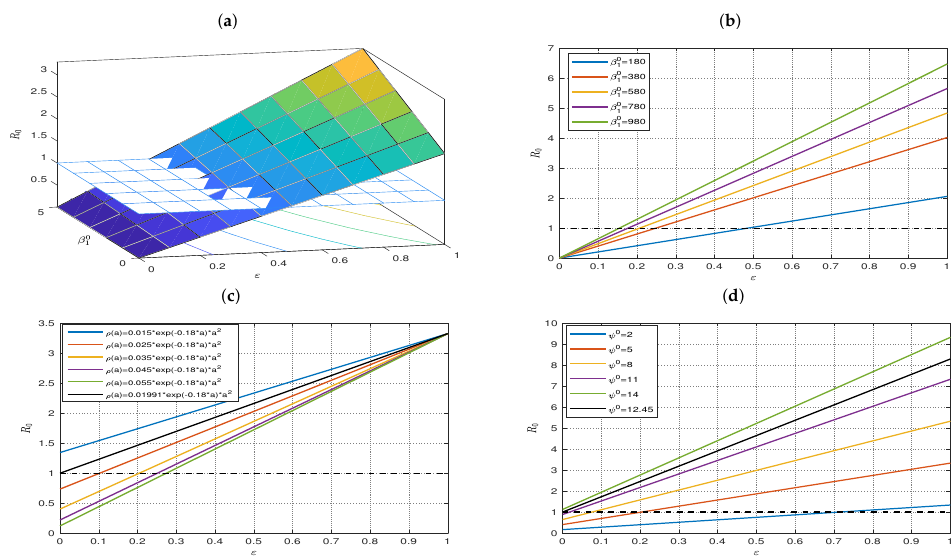
Figure 10. Sensitivity of the main parameters of model (4) on the basic production number R 0 : ( a ) the ) ; ( b ) the two-dimensional graph of function three-dimensional graph of function R 0 = R 0 ( ε , β 0 1 R = R ( ε , β 0 ) for some fixed β 0 ; ( c ) the two-dimensional graph of function R 0 = R 0 ( ε , ρ 0 ) for some 0 0 1 1 fixed ρ 0 ; ( d ) the two-dimensional graph of function R 0 = R 0 ( ε , ψ 0 ) for some fixed ψ 0